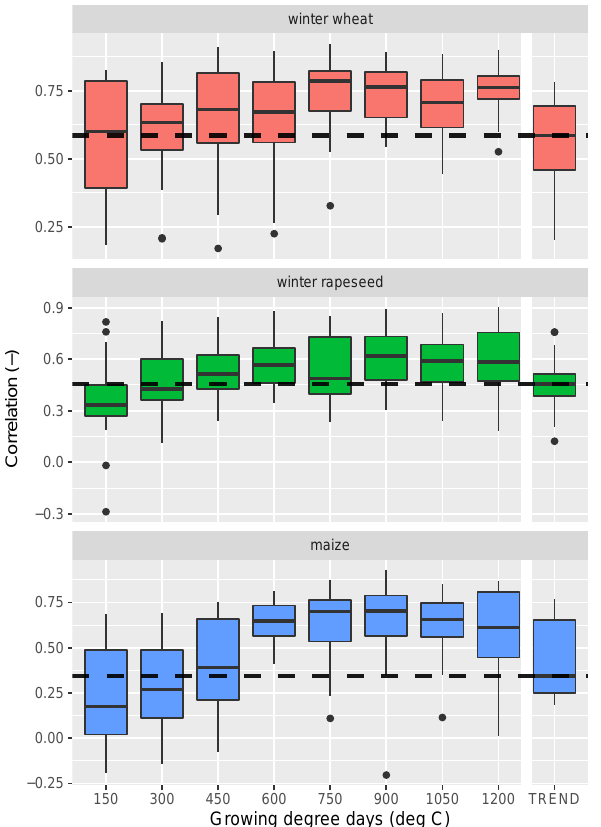
Figure 12. Distributions of temporal correlations for different GDD levels between crop yield predic- tions and reference statistics. Additionally, the performance of linear trend models is shown on the rightmost box. Dashed line denotes median correlation of the linear